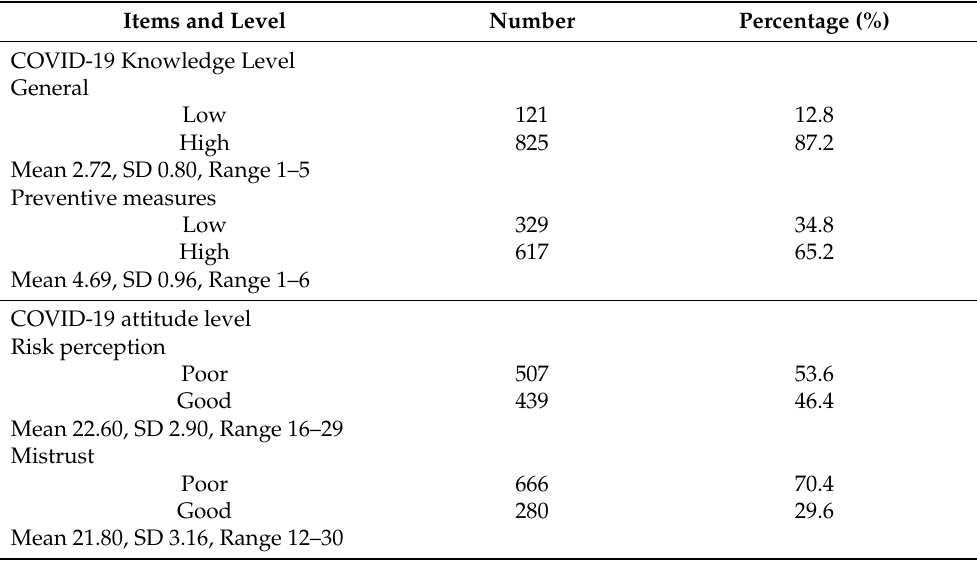
Table 2. Knowledge and attitude levels on COVID-19 prevention.